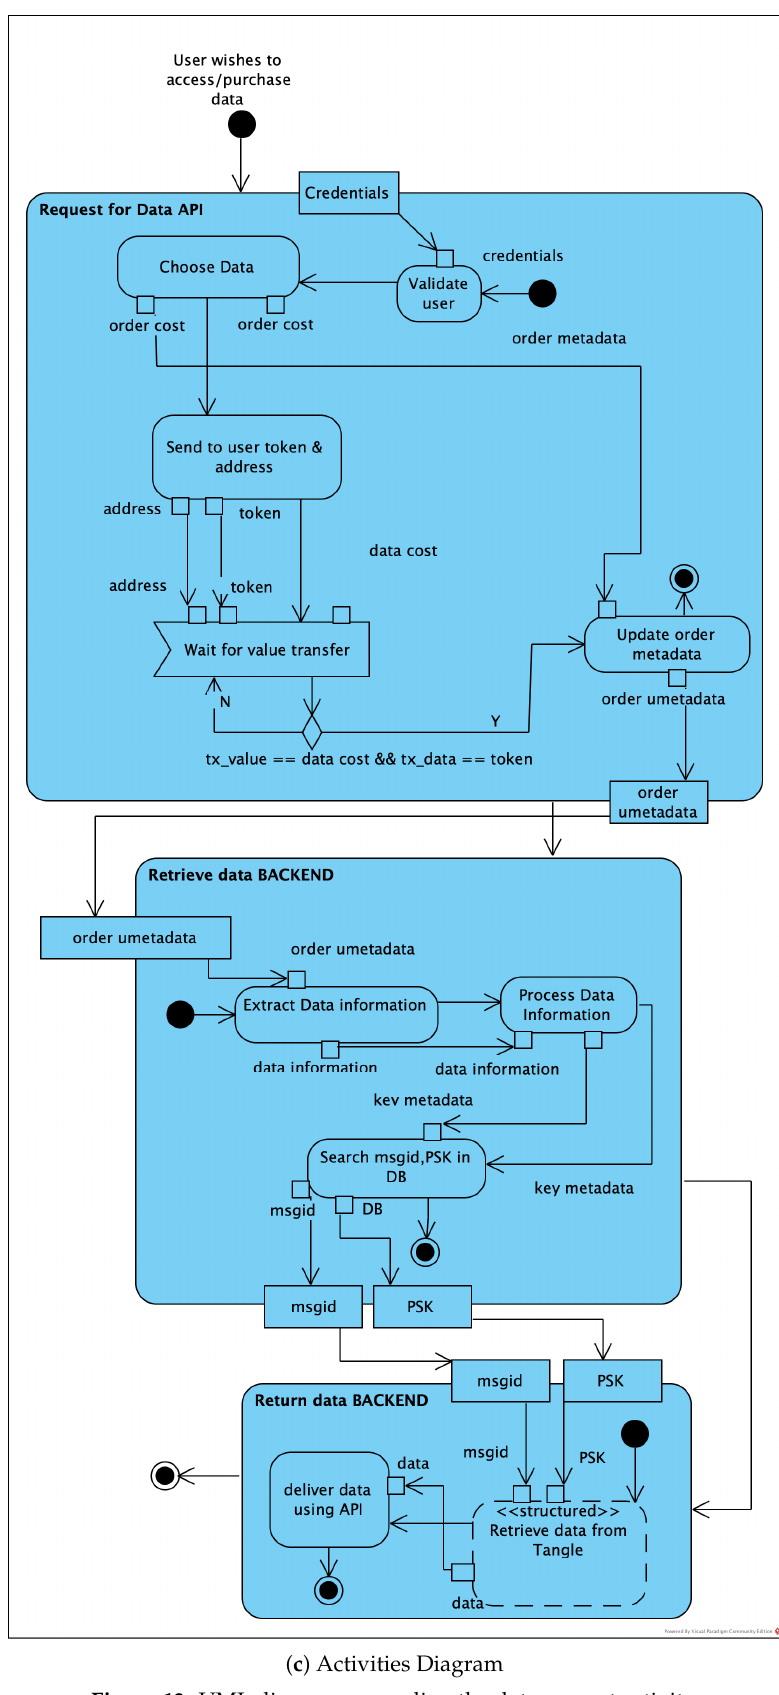
Figure 13. UML diagrams regarding the data request